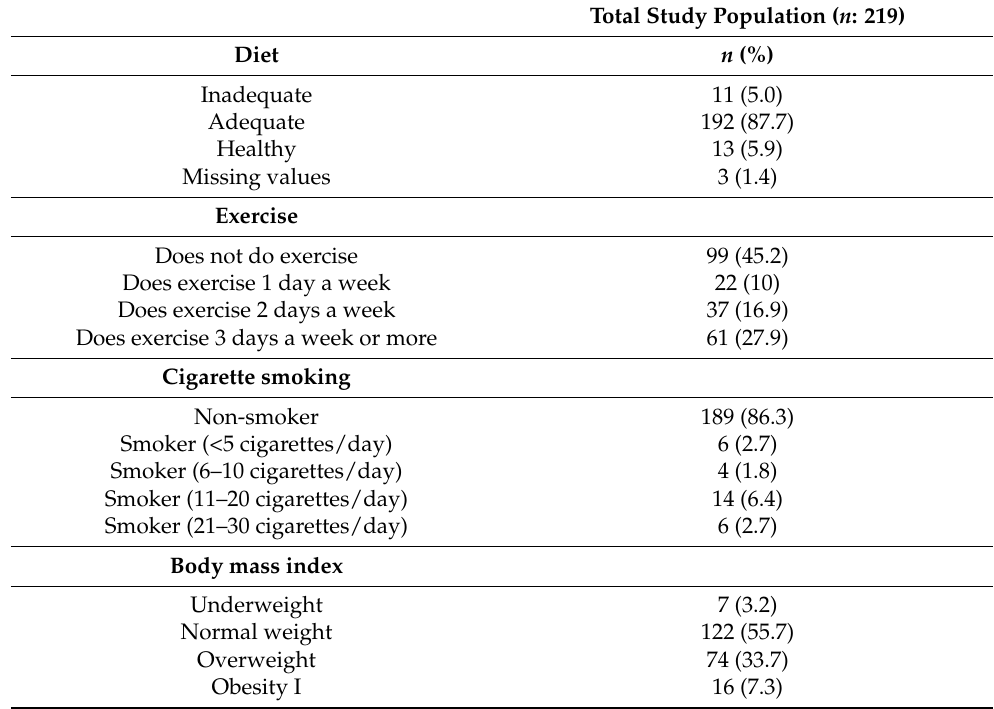
Table 2. Variables related to diet, exercise, tobacco consumption, and body mass